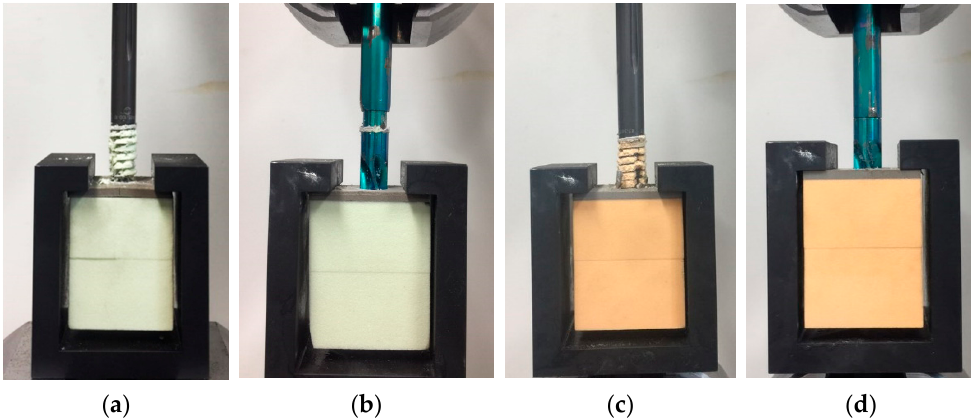
Figure 6. Pull-out specimen at the final failure: ( a ) screw (0.14 g/cm 3 ); ( b ) helical blade (0.14 g/cm 3 ); ( c ) screw (0.35 g/cm 3 ); ( d ) helical blade (0.35 g/cm 3 ).